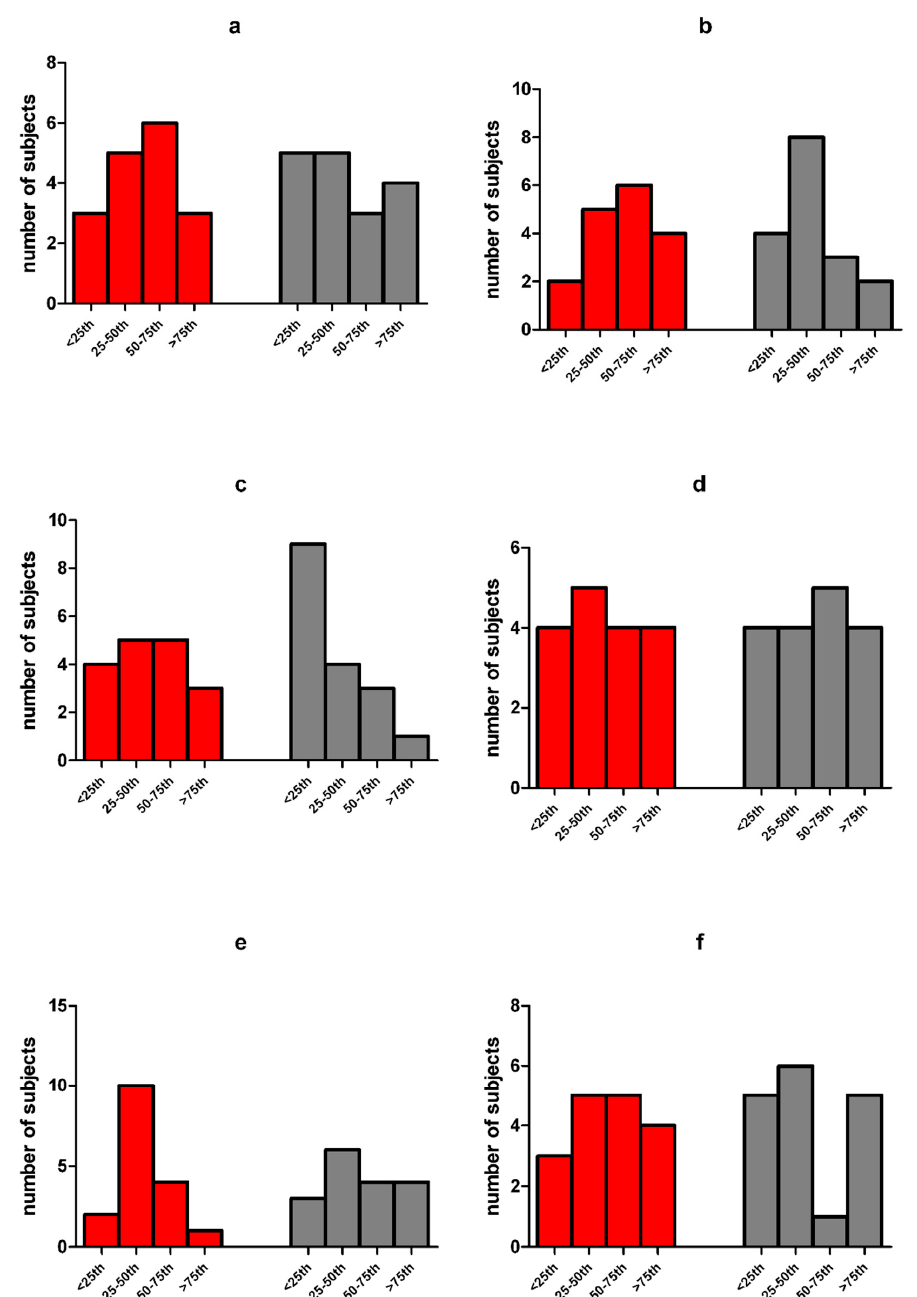
Figure 3. ( a – f ) Distribution of PCD patients and controls in the classes of percentile of PSGWBI subscales. Legend: the psychological general well-being index (PSGWBI) questionnaire was administered to primary ciliary dyskinesia (PCD) patients (n = 17) and healthy controls (n = 17) older than 15 years. The PSGWBI is organized in six subscales: ( a ) anxiety; ( b ) depression; ( c ) well-being; ( d ) self-control; ( e ) general health; ( f ) vitality. Classes of percentile were defined for subscales, according to gender and age, as follows: < 25th pc: ‘severe distress’; between 25th and 50th percentile: ‘moderate distress’; between 50th and 75th percentile: ‘no distress’; > 75th percentile: ‘positive well-being’. Red columns indicate PCD patients and grey columns indicate healthy controls. No significant di ff erence between the number of PCD patients and controls with subscale scores < 25th percentile was found ( a – f ). Fewer PCD subjects than controls reported ( a ) anxiety, ( b ) depression, ( c ) di ffi culties relating well-being or ( f ) vitality feelings, whereas more di ffi culties were with ( d ) self-control and ( e ) general health were found in a higher proportion of PCD cases than in